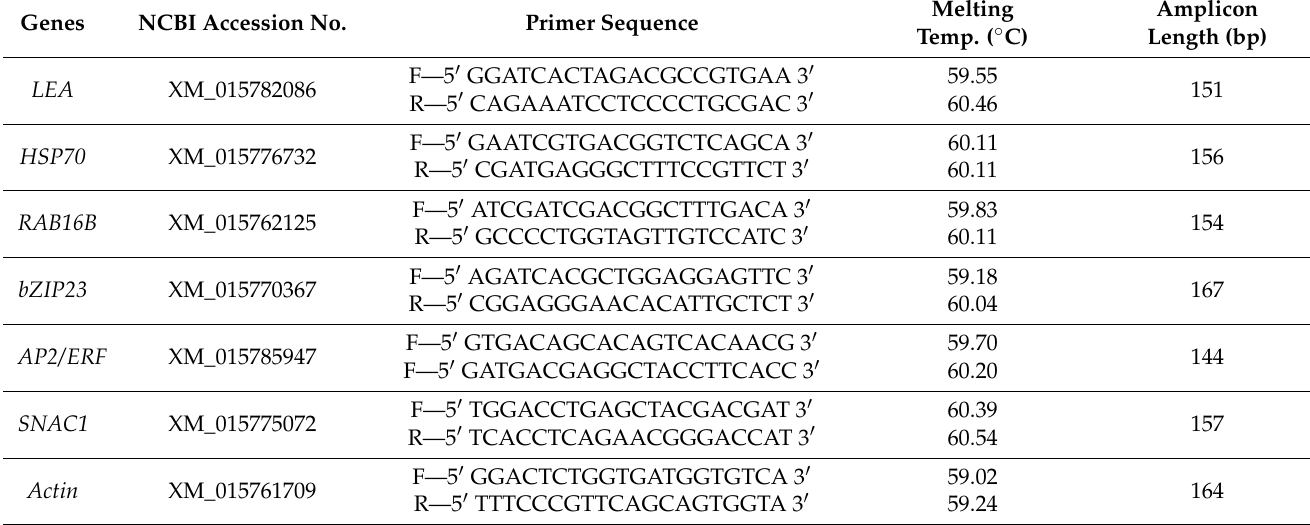
Table 3. Primers details used in qPCR